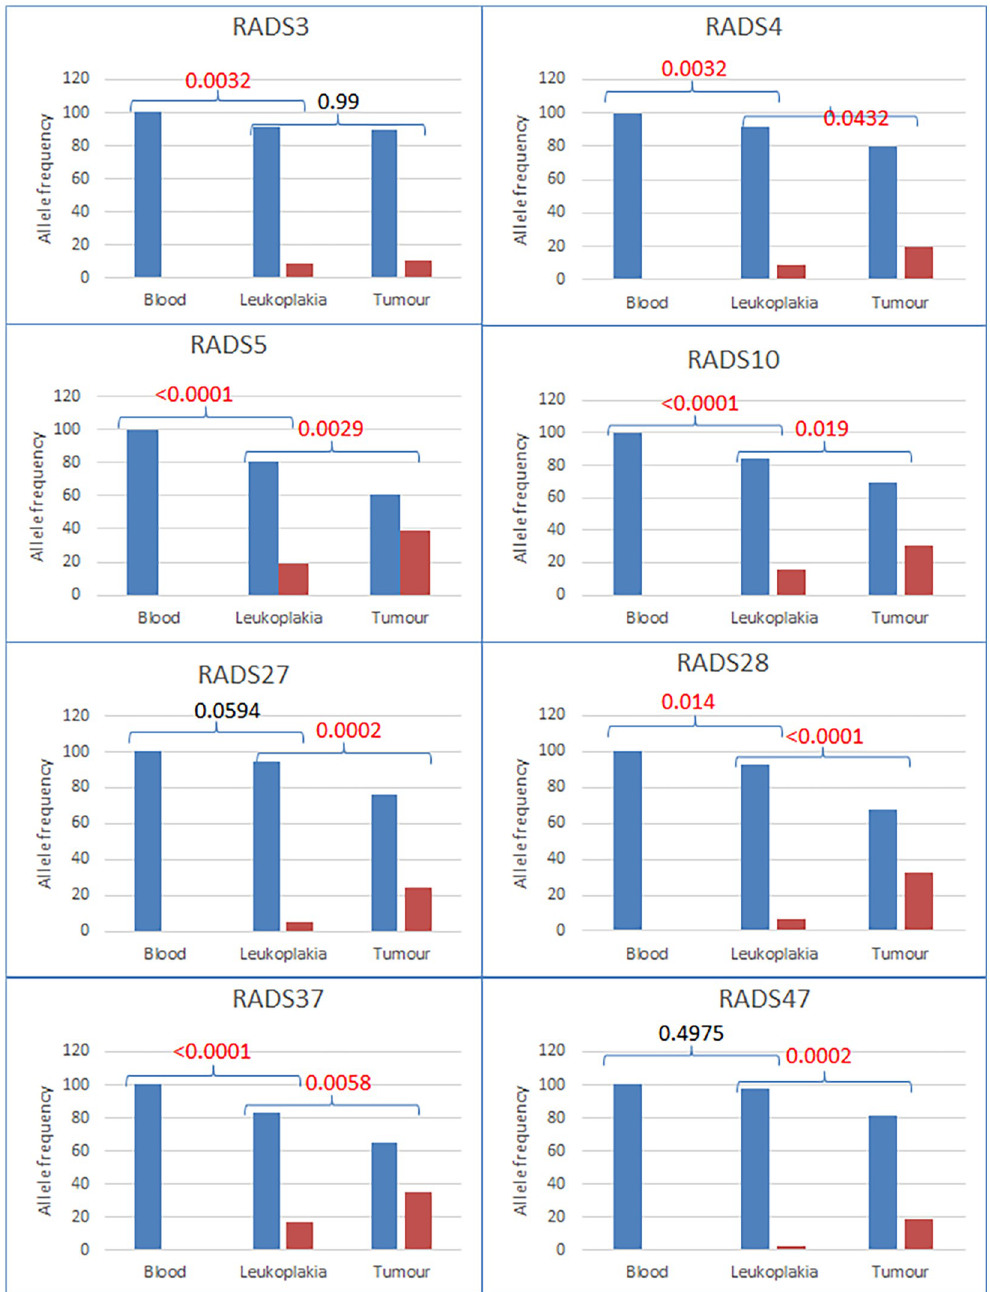
Fig 2. Wild type and mutated allele frequencies of CASP8 in blood, leukoplakia and tumor tissues of the patients. Wild type (blue bars) in blood DNA and mutated allele (red bars) frequencies in adjacent (located within 2–5 cm of tumor sites) leukoplakia and cancer tissues were plotted. Both leukoplakia and cancer tissues had identical type of mutation. For each of the plotted samples, mutated allele was found to be absent in blood DNA but present in leukoplakia and tumor tissues. Its frequency increased in cancer compared to adjacent leukoplakia tissue (p < 0.05 for seven samples while p > 0.05 in one sample).